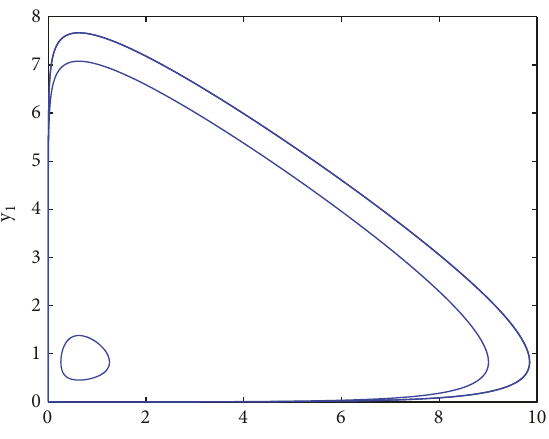
Figure 2: The two-dimension phase diagram of the stable solution of system (30) under the same condition as Figure 1 except 𝑄 = 0 .